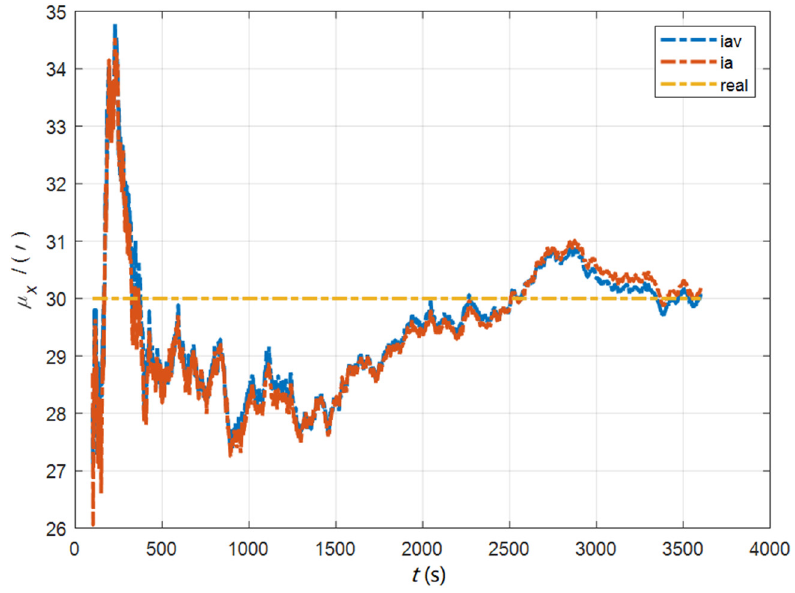
μ μ in the cases of the initial misalignment angles in the cases of the initial misalignment angles x